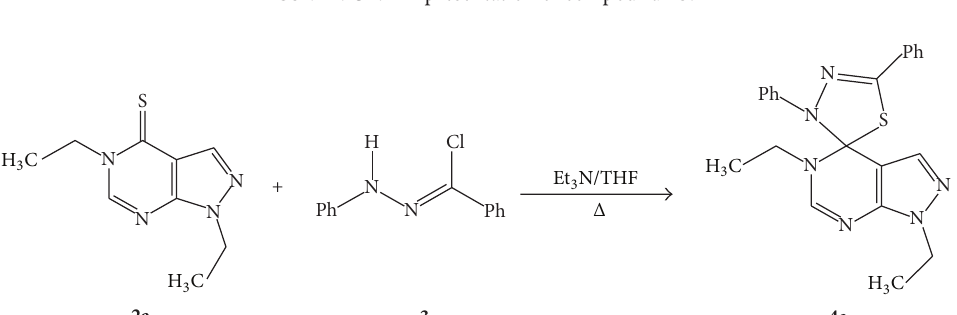
Figure 4: ORTEP presentation of compound 2b